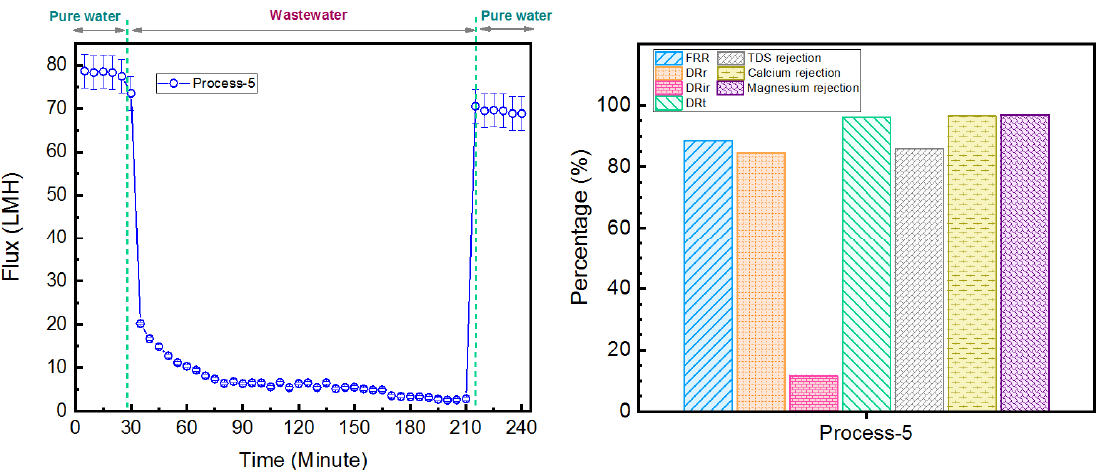
Figure 6. Permeation flux and fouling characteristics of Process-5. Operating conditions were set at a transmembrane pressure of 350 psi, solution temperature of 25 ◦ C and stirring speed of 1500 rpm.